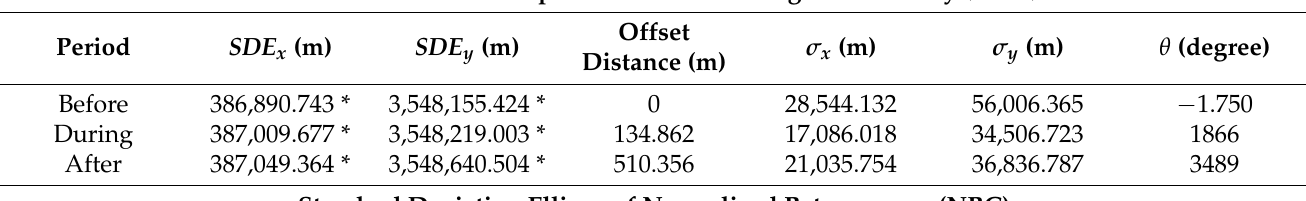
Table 7. The results of SDE by using values of NDC and